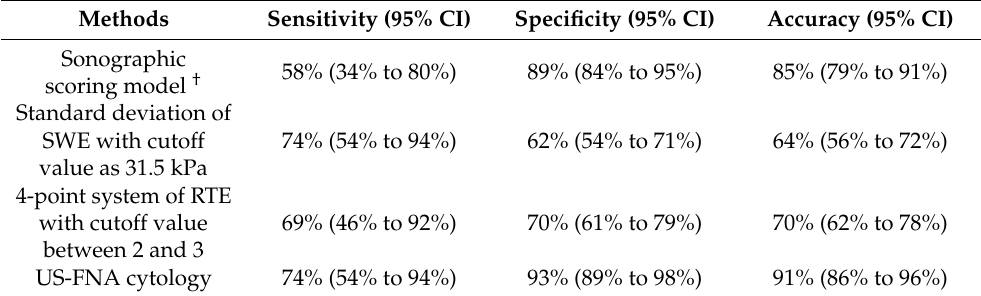
Table 3. Comparison of the different methods for diagnosing malignant salivary gland tumors.